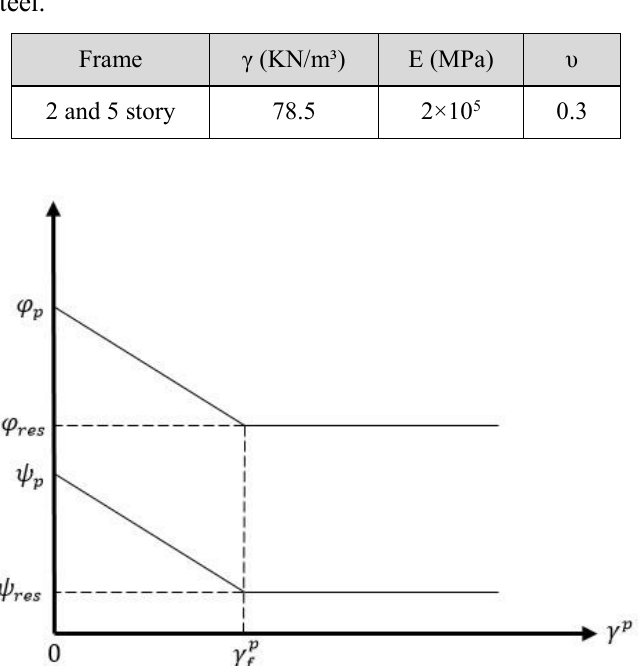
Characteristics of used steel.